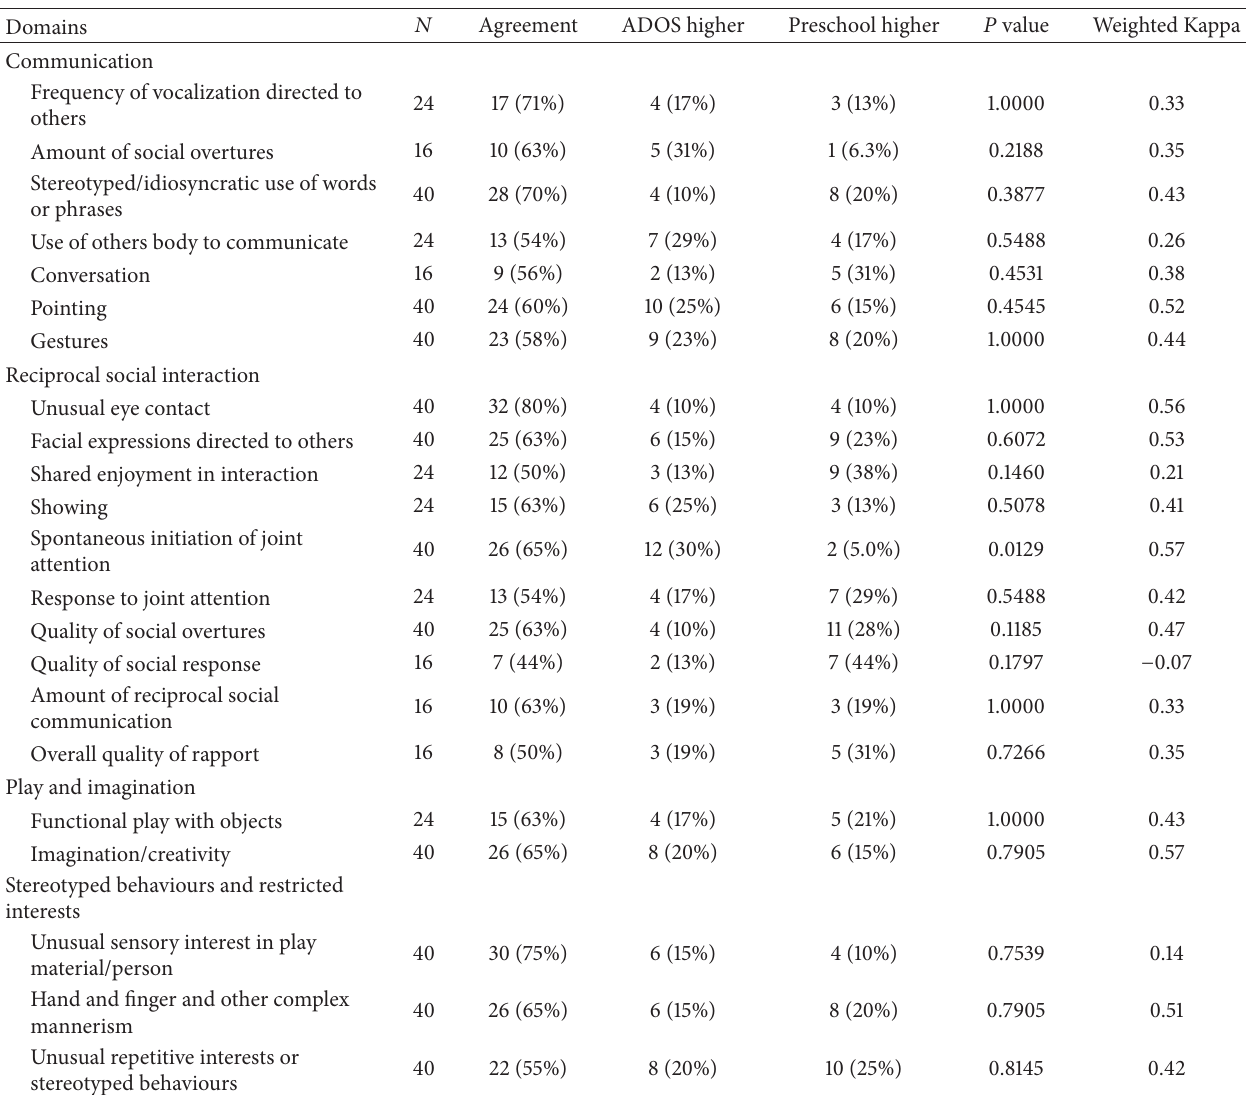
Table 3: Agreement between ADOS and preschool observation findings (module 1, 𝑛 = 24 ; module 2, 𝑛 = 16 ). Number of higher score in each type of observation is